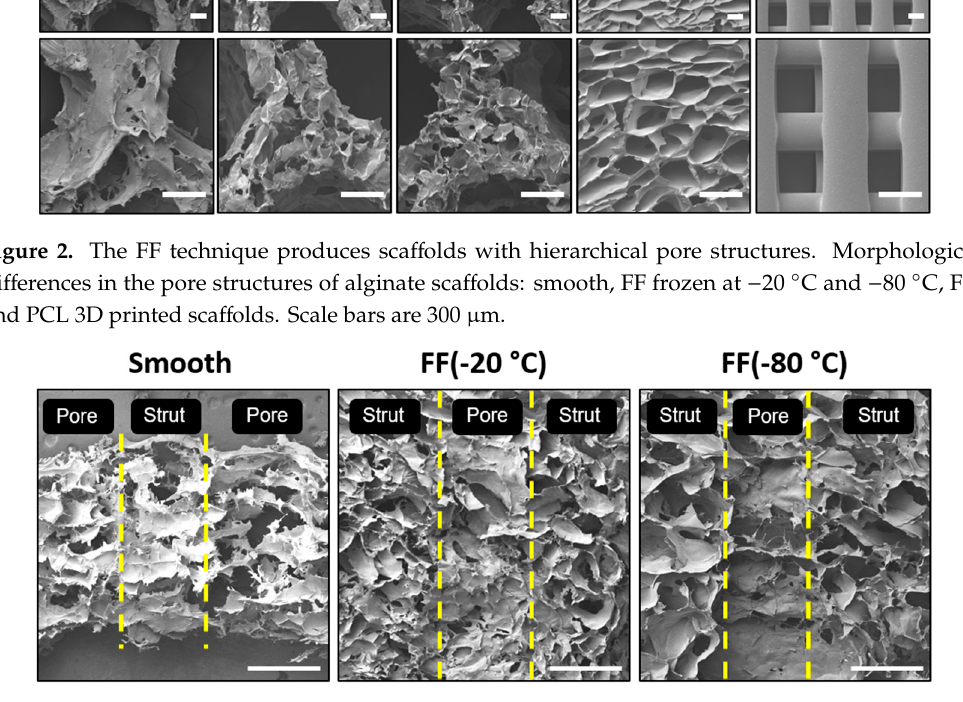
Figure 2. The FF technique produces scaffolds with hierarchical pore structures. Morphological differences in the pore structures of alginate scaffolds: smooth, FF frozen at − 20 °C and − 80 °C, FC, and PCL 3D printed scaffolds. Scale bars are 300 μ m.